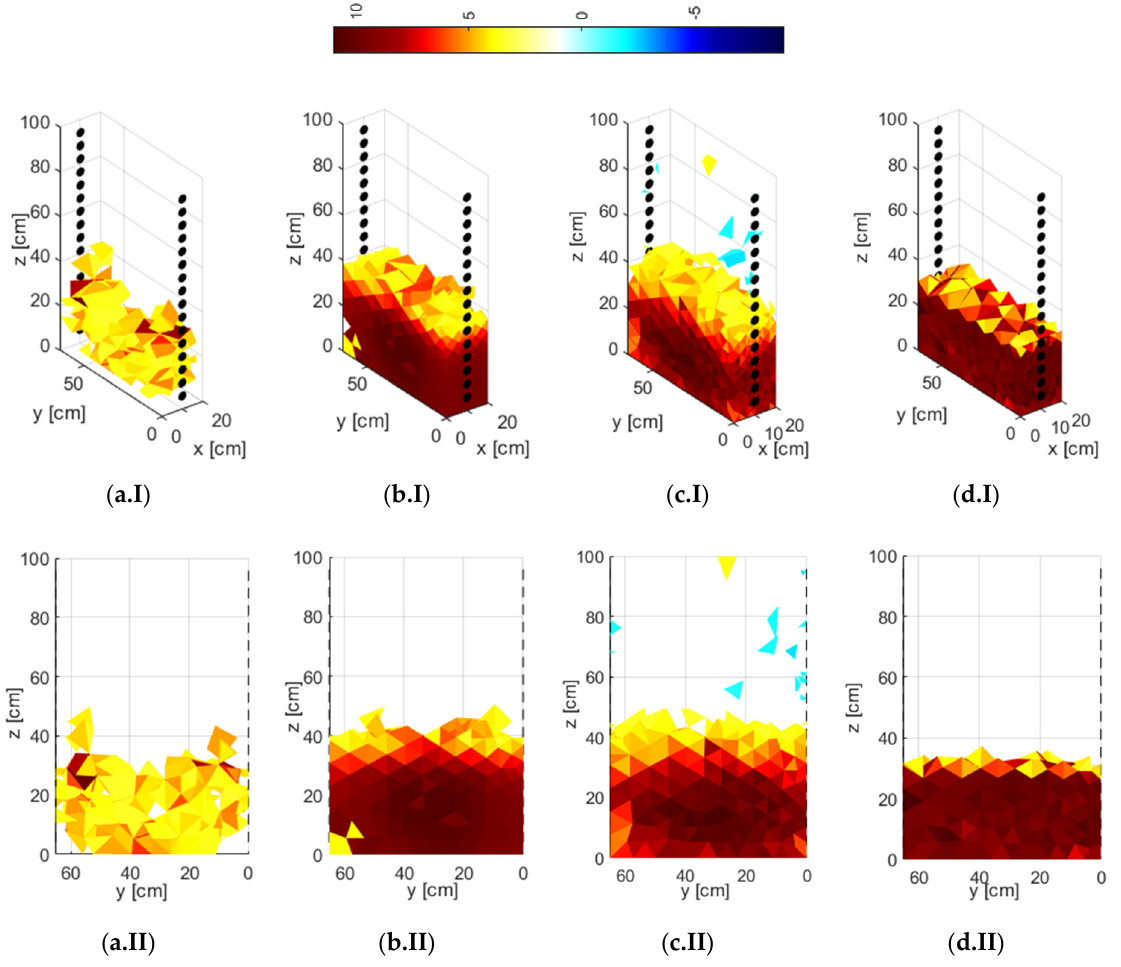
Figure 14. Reconstructions obtained from simulation measurements: ( a.I ) and ( a.II) refers to GN, ( b.I ) and ( b.II ) refers to LR-SVM, ( c.I ) and ( c.II ) refers to LR-LS, ( d.I ) and ( d.II ) refers to ANN.